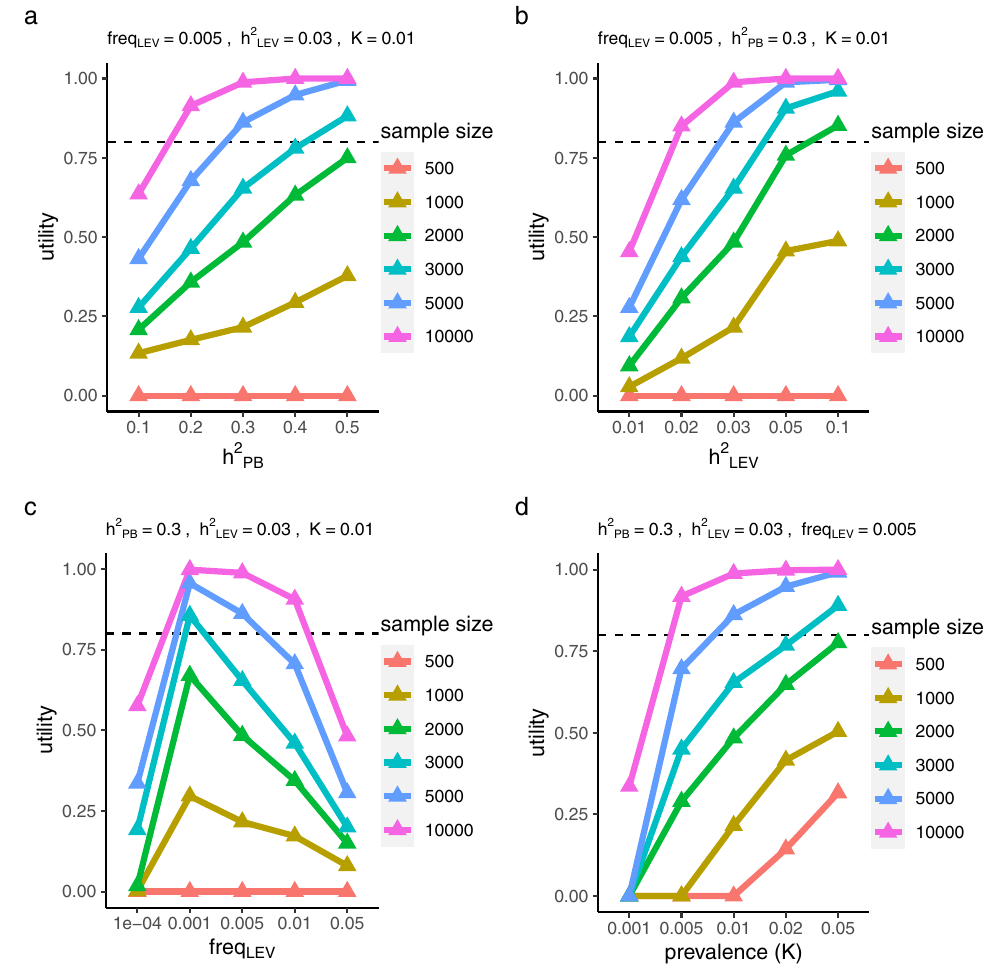
Fig. 3 Utility of PB-LEV correlation under liability-threshold model. We simulated the effect sizes for common and rare variants and calculated the probability of disease risk for each individual using real genotype data. Cases and controls were de fi ned by the liability threshold. The utility is de fi ned as the proportion of simulations for which, among cases, a signi fi cantly lower ( P < 0.05) PB in LEV carriers than in noncarriers is observed. We varied the a heritability attributable to the common-variant polygenic component, b heritability captured by the LEV and c its allele frequency, and d disease prevalence while fi xing all other parameters. Two-sample Wilcoxon test was performed to test whether PB was lower in LEV carriers than in noncarriers (one-sided test) in cases. The utility, to be contrasted with power, was calculated as the proportion of signi fi cant ( P < 0.05) test results in 500 simulations, with different seeds for sampling causal variants and subjects. Broken line at 80% is a reasonable utility threshold. The results under the polygenic genetic architecture are shown. Results for the other two genetic architecture models can be found in Supplementary Fig. 1. Source data are provided as a Source Data fi